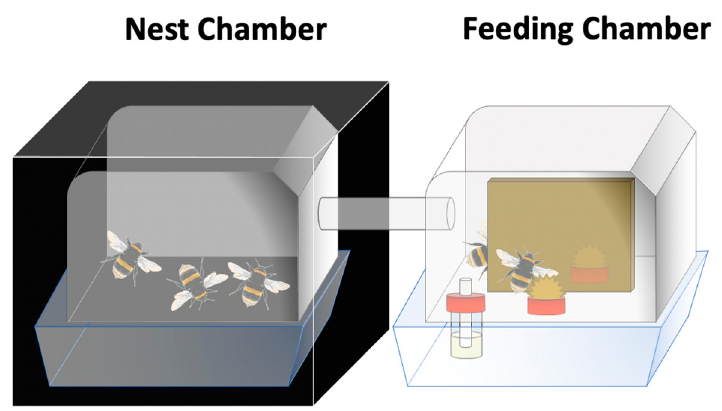
Figure 2. Experimental setup (i.e., two-box system) used for the feeding choice experiment. Nest chamber was kept into the dark with one small willow candy for brood initiation; feeding chamber was provided with syrup, kept under 12 h natural light conditions and divided in two compart- ments for worker pollen choice. Workers were enabled to freely move between the two chambers through a tube connection. Three pollen combinations were used namely, heather/multifloral, sunflower/multifloral, and heather/sunflower. All combinations were tested with infected and unin- fected microcolonies. Nine microcolonies were used per treatment (infection*pollen combination).